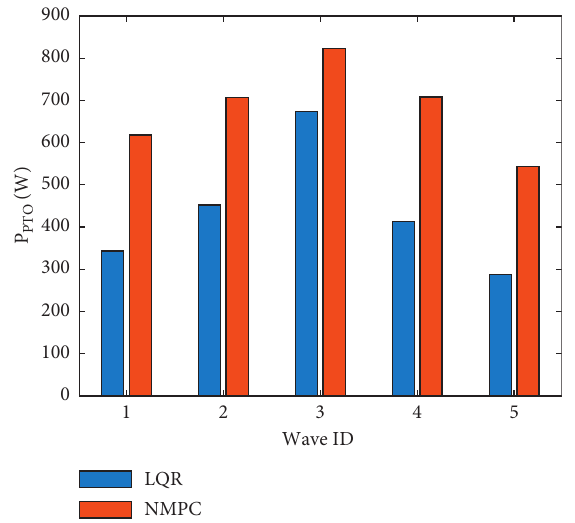
Figure 8: The power comparison of LQR and NMPC when ex- posed to the regular wave environment.